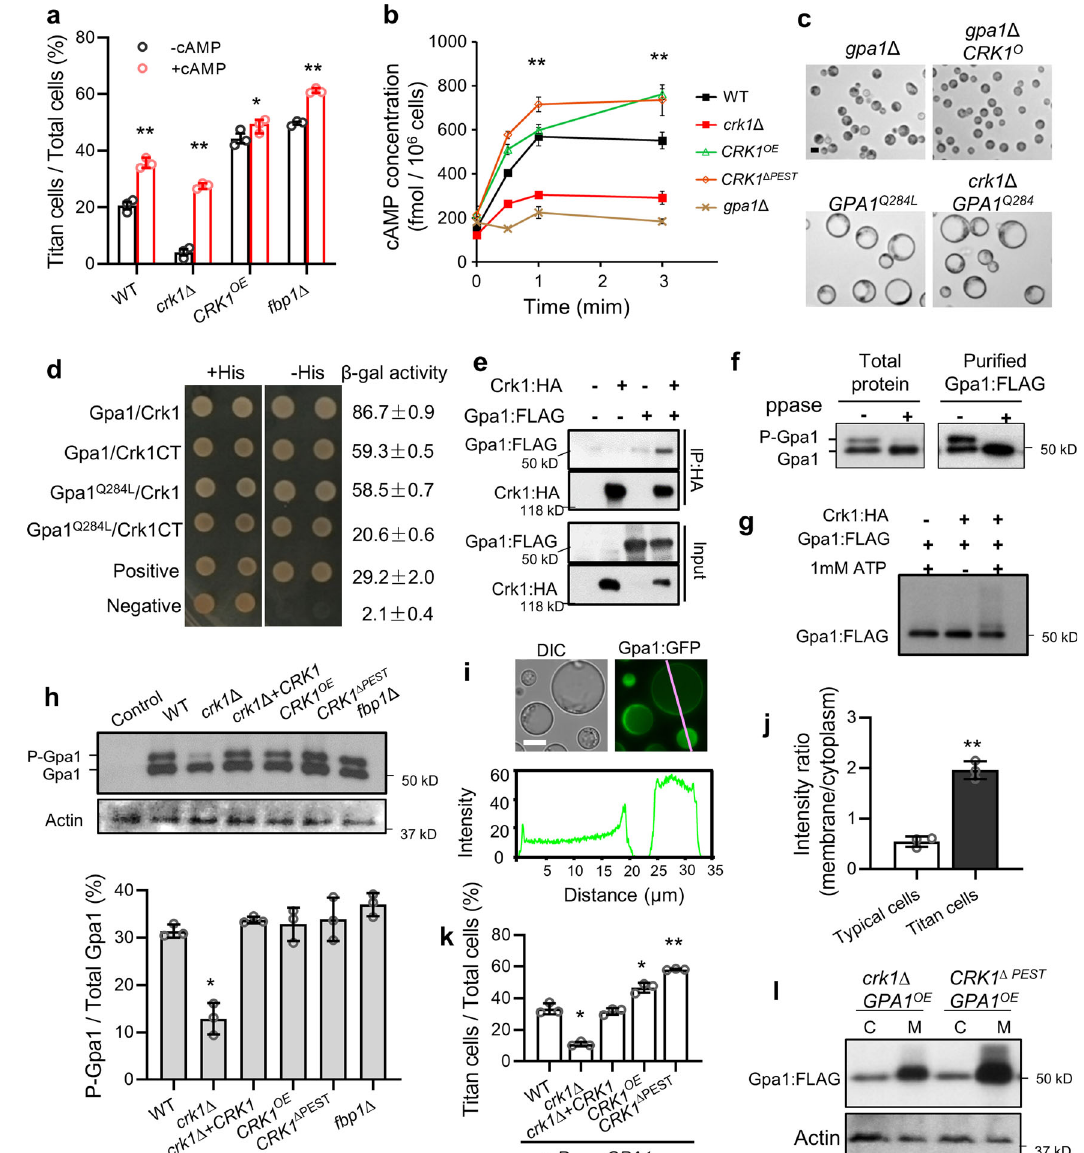
Fig. 4 | Crk1 regulates titan cell formation through the Gpa1-cAMP signaling pathway.a Titancellpercentageunderinvitrotitancellinducingconditionsinthe absence or presence of 10mM extracellular cAMP. Error bar indicates 95% con- fi dence interval of the median for 3 independent experiments. Statistical analysis was performed based on two-sided Mann – whitney test. * P =0.030, ** P =0.02. b MeasurementofcAMPproductioninresponsetoglucose.Statisticalanalysiswas performed with the Kruskal – Wallis nonparametric test for multiple comparisons. ** P <0.0001. c Representativecellimagesoftheindicatedstrainsafterincubatedin minimal medium (MM) for 3 days at 30°C. Bar, 5 µ m. d The interaction between Crk1 and Gpa1 in a yeast two-hybrid interaction assay. Gpa1 Q284L , Gpa1 dominant active allele; Crk1CT, C-terminus of Crk1. e Co-immunoprecipitation assay. Lysates from strains expressing either Gpa1:FLAG or both Gpa1:FLAG and Crk1:HA, and immunoprecipitated using anti-HA, then analyzed by immunoblotting using anti- FLAGandanti-HA(IP). f Totalproteinextractsorpuri fi edGpa1:FLAGfromthestrain expressing P GDP1 -GPA1:FLAG (CUX1196) were treated with protein phosphatase (ppase) and Gpa1 signal was detected using anti-FLAG. g In vitro kinase assay was perform for puri fi ed Gpa1:FLAG that was pre-treated with protein phosphatase (ppase),andthenmixedwithpuri fi edCrk1-HAintheabsence( − )orpresence(+)of ATP. The Gpa1 was detected using anti-FLAG. h Gpa1 phosphorylation in titan cell inducingconditions.TotalproteinfromstrainsexpressingGpa1:FLAGwasanalyzed by western blotting with an FLAG antibody (top) and the abundance of